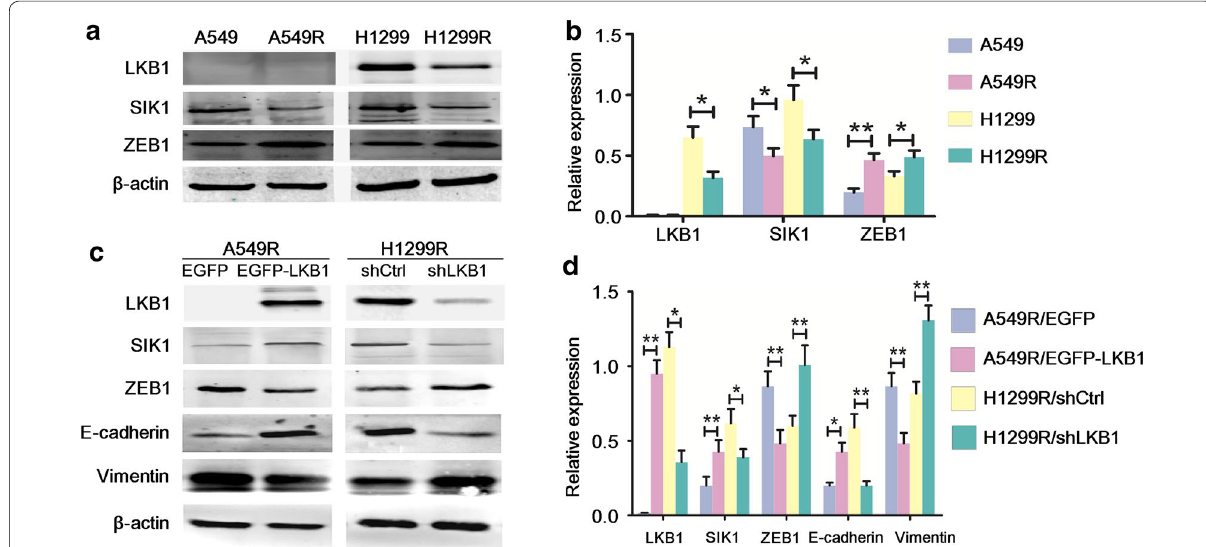
Fig. 4 Liver kinase B1 (LKB1)‑salt‑inducible kinase 1 (SIK1) signaling suppressed the epithelial–mesenchymal transition phenotype of A549R and H1299R cells. a Western blot analysis of LKB1, SIK1, and Zinc‑finger E‑box‑binding homeobox factor 1 (ZEB1) expression in A549, A549R, H1299, and H1299R cells. b The quantification of the protein levels in a . * P < 0.05; ** P < 0.01 (Student’s t test). c Western blot analysis of LKB1, SIK1, ZEB1, E‑cadherin, and vimentin expression in A549R cells transfected with enhanced green fluorescent protein (EGFP) or EGFP‑LKB1 ( left panel ), and H1299R cells transfected with shCtrl or shLKB1 ( right panel ). d The quantification of the protein levels in c . * P < 0.05; ** P < 0.01 (Student’s t test)